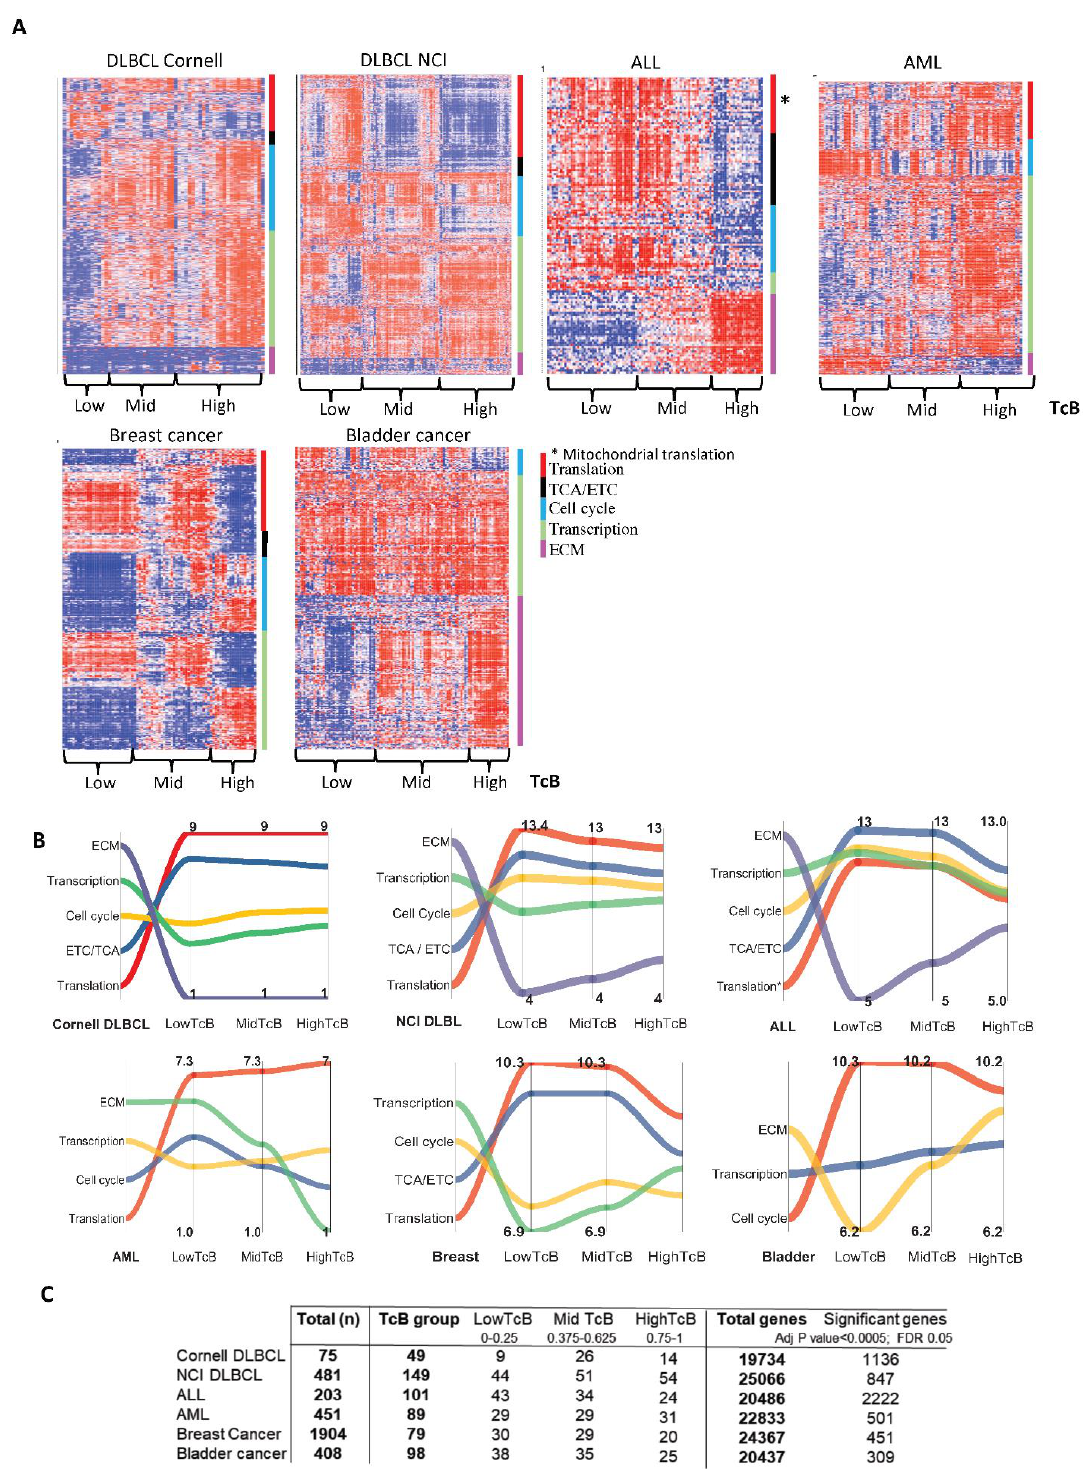
Figure 3. Homogeneous biological patterns in malignancies identified by TcB analysis. ( A ) The heat map represents higher order biological processes derived from collapsing reactome-enriched biological pathways determined from TcB subgroup analysis of independently analyzed tumor transcriptomes. A blue-to-red gradient indicates row variance. ( B ) Ribbon graphs of average log 2 values of gene expression values for genes represented in higher-order processes shown in ( A ). ( C ) Summary of the numbers of patients/genes in the original tumor transcriptomic datasets and the TcB partitioned